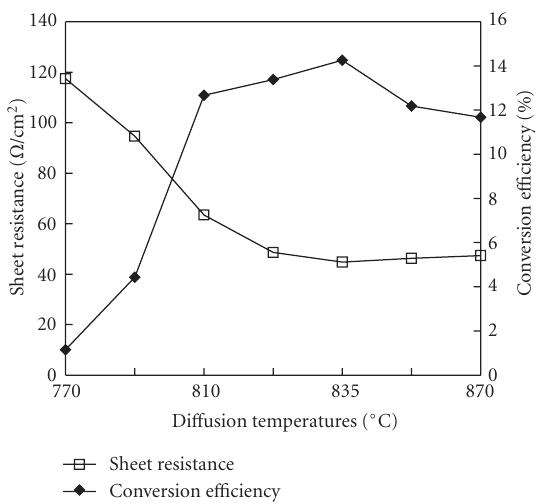
Figure 2: The sheet resistance (in Ω /cm 2 ) and conversion e ffi ciency (in %) with respect to temperatures (from 770 ◦ C to 900 ◦ C) of the solar-cell prototypes with and without drive-in di ff usion processes.